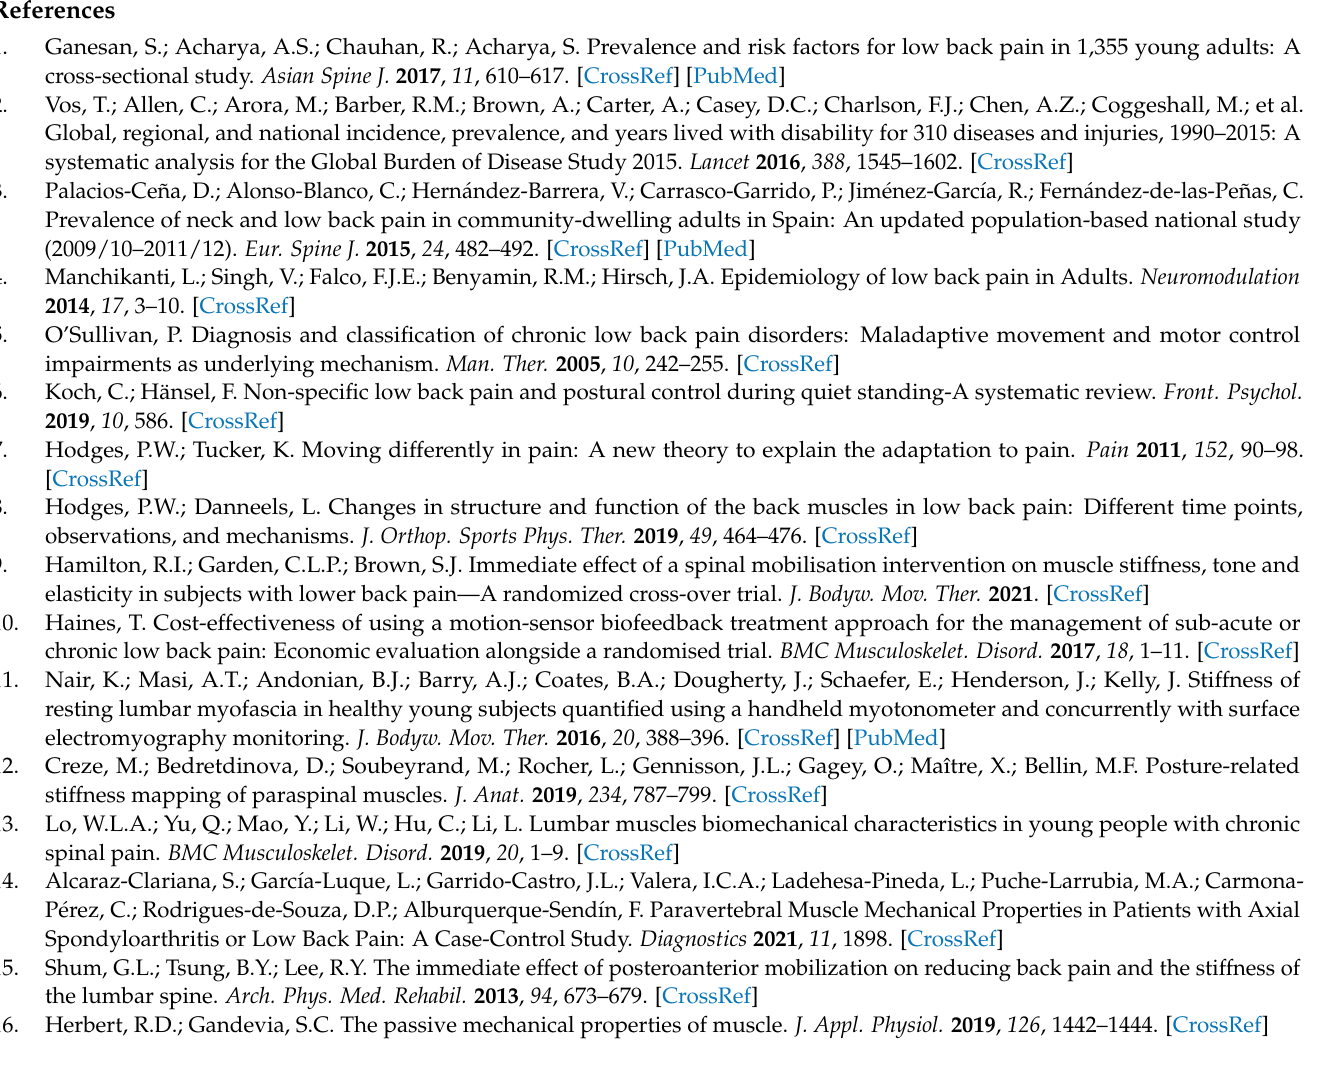
flexion, Figure S4: Left lateral flexion, Figure S5: Right rotation, Figure S6. Left